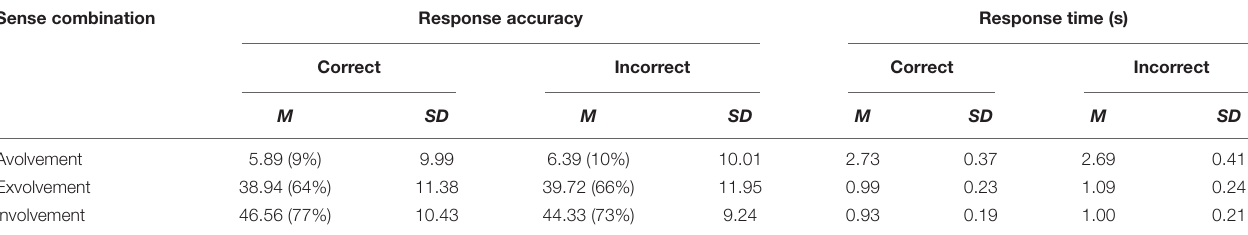
FIGURE 3 | A sample ERP trial (Badiane is brown) in an experimental block of the task. TABLE 4 | Mean values (M) and the standard deviations (SD) for RA and